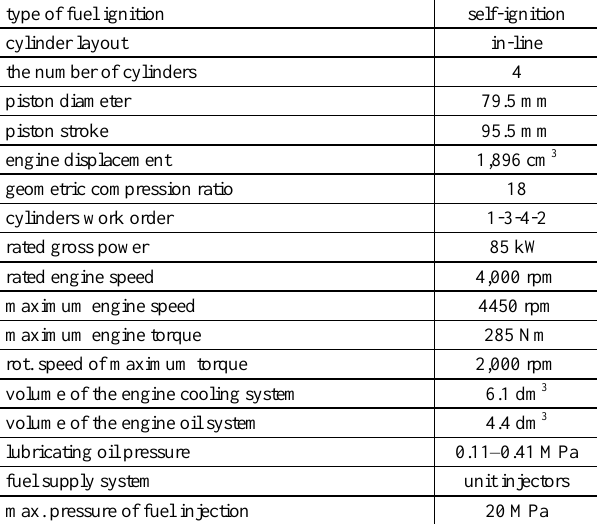
Table 2. Technical parameters of VW 1.9 TDI (type AJM)